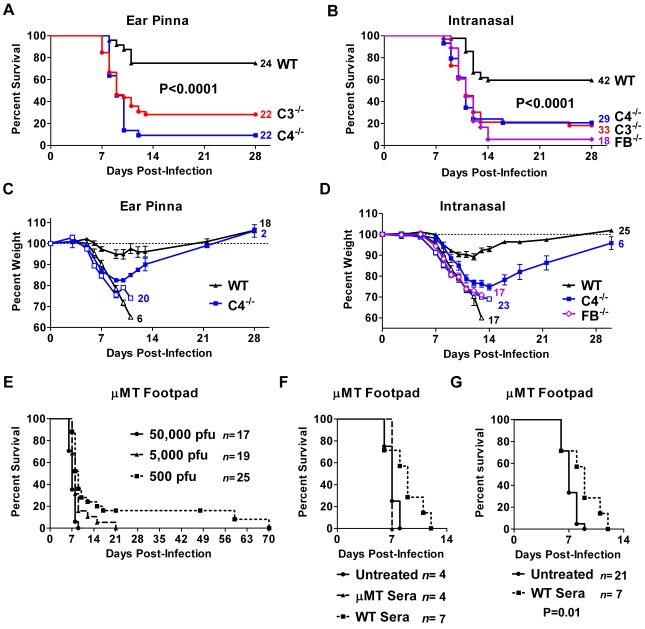
Deficiency of classical or alternative pathway components reduced survival.(A,C) C4−/− mice have greater mortality than wild-type (WT, P<0.0001). C4−/− mice were compared to C3−/− and wild-type mice following inoculation with ∼700 pfu ECTV via the ear pinna. The weights of the surviving animals (filled symbols) are separated from those that succumbed (open symbols). The number of animals in each group is at the right of the line. The data combine four separate experiments. (B,D) Increased mortality in C4−/−, FB−/−, and C3−/− mice compared to wild-type (P<0.0001). Mice received 100 pfu intranasally. Data are displayed as described above. Curves are generated from multiple experiments (n for WT = 8, C4 = 6, FB = 4, C3 = 7). The surviving FB−/− mouse was omitted from (D) for clarity. (E) μMT mice are susceptible to ECTV via the footpad route. μMT mice were challenged with ECTV, and a dose-dependent increase in mortality was observed. The 50,000 pfu dose differs from 5,000 pfu (P = 0.006) and 500 pfu (P<0.0001), and the lower doses differ from each other (P = 0.045). Survival curves were constructed from four separate experiments, and the number of animals is to right of the legend. (F,G) Treating μMT mice with natural antibody delays mortality. μMT mice were challenged with high doses of ECTV (100,000 pfu) via the footpad route in two separate experiments. Some mice received wild-type sera as a source of natural antibody, while others received μMT sera (1 ml on day minus-1 followed by 0.5 ml on days 0, 2, 4, 6, 8, 10). The untreated curve in (G) includes the historical control data from the untreated mice at 50,000 pfu in (E). The number of animals in each group is next to the legend.